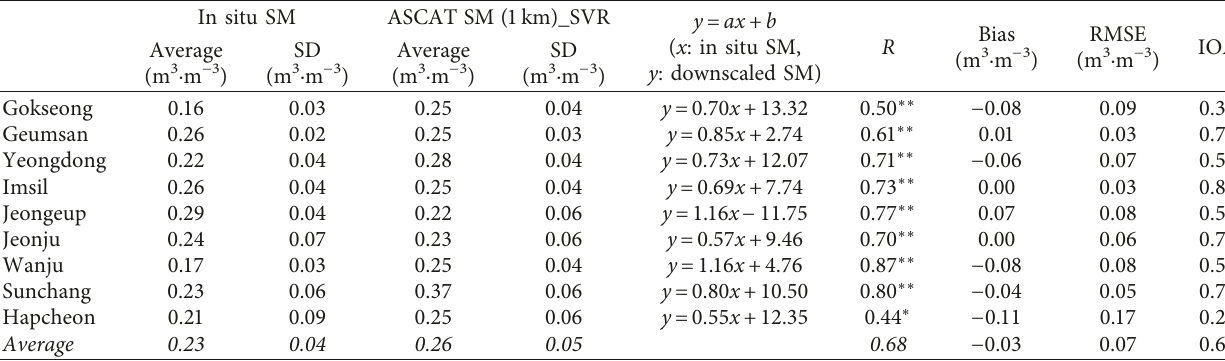
Table 7: Comparison between in situ and downscaled (1km) ASCAT SM_SVR.